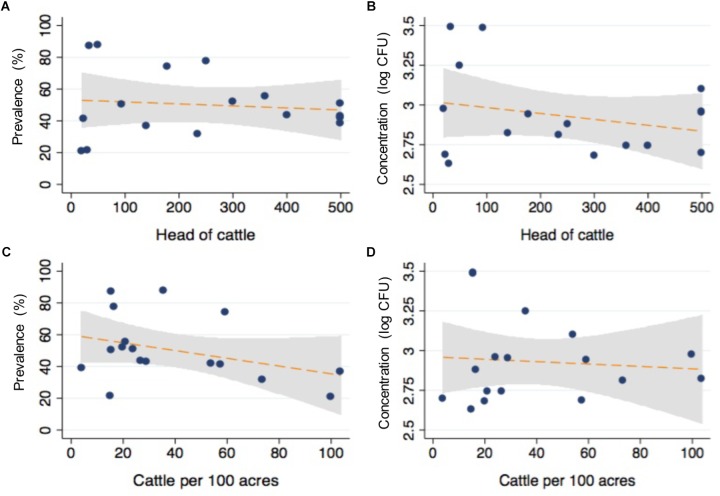
Relationship between cattle density and CRB isolated from commercial beef farms. The relationship between total number of cattle (A,B) and the density (C,D) of cattle per 100 acres with the prevalence and concentration of CRB from fecal samples are presented as scatter plots from values corresponding to individual farms (blue dots), with the corresponding fits from linear regression models with 95% confidence intervals for the slope (orange line, gray shaded region).